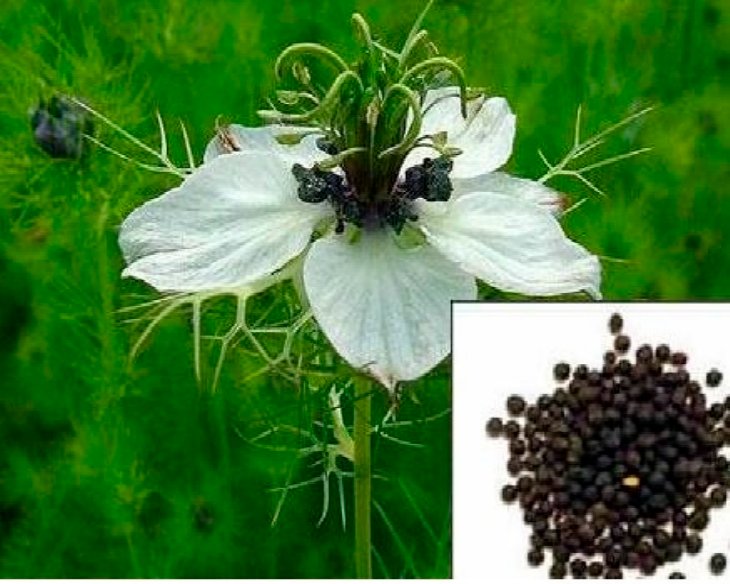
Figure 8. Image of Nigela sativa plant. Source: Pure Life 2017 [111].